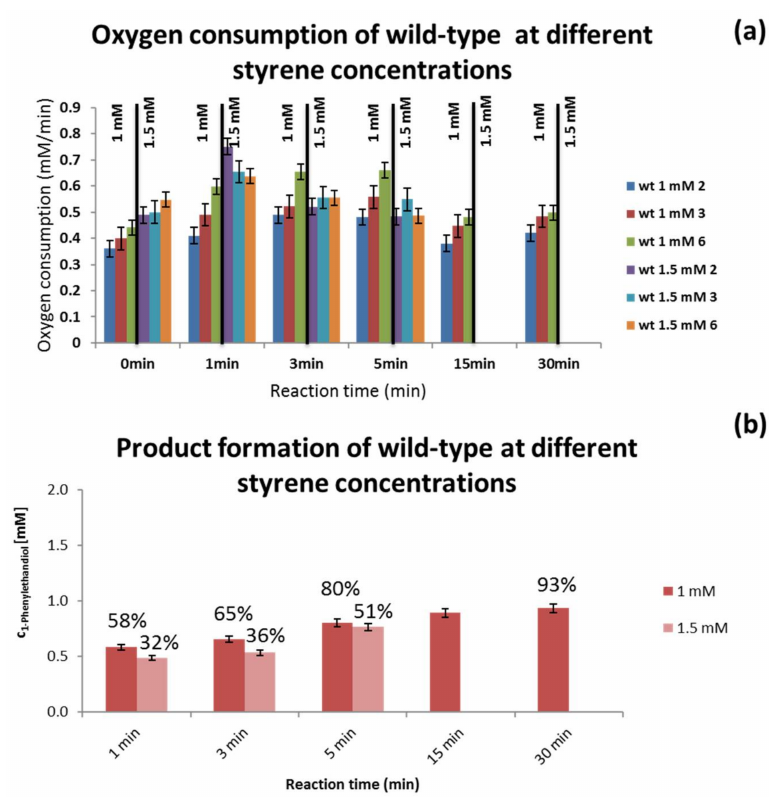
Figure 8. Oxygen ( a ) and GC ( b ) measurements of the reaction wt cells in the presence of two styrene concentrations (1 and 1.5 mM).